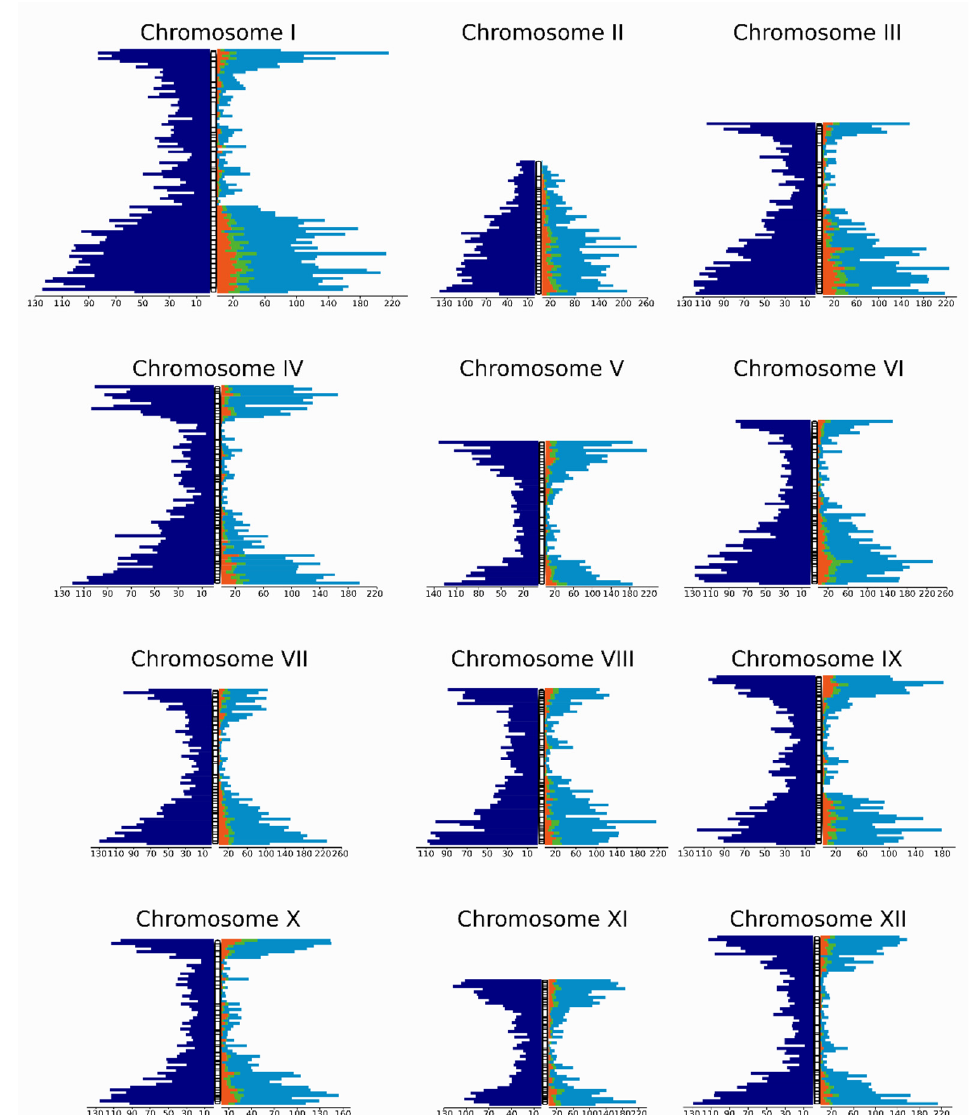
Figure 1. Density of genes and SNP markers per chromosome. Each bar indicates density in a 1 Mbp bin. Blue bars show gene density; light blue, the total SNPs mapped; green, SNPs without missing data; and orange, SNPs without missing data and with best quality. Number of genes or SNPs per Mbp are indicated at the bottom of each sub-figure.